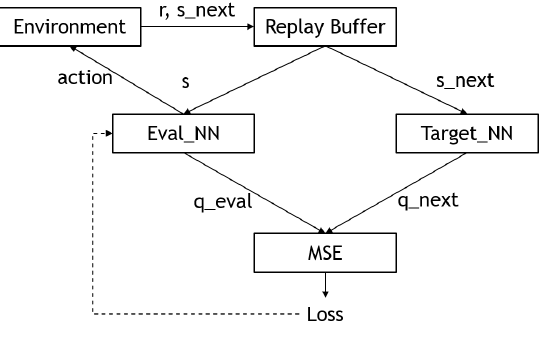
Figure 4. Flowchart of